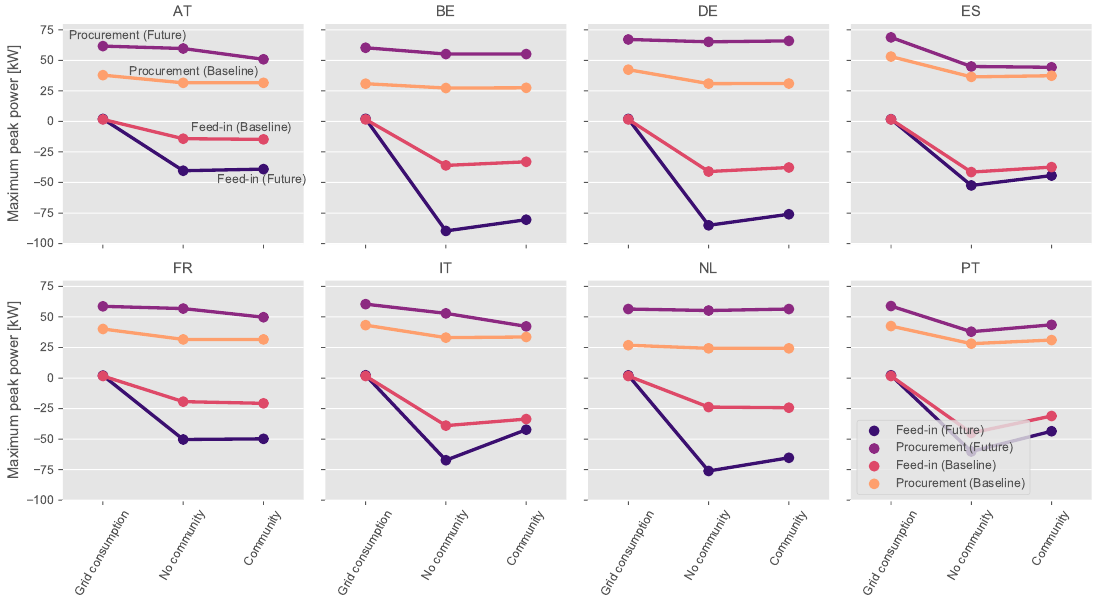
Figure 8. Peak power within one year for procurement and feed-in for all countries. The results represent discrete data (four data points per scenario). The subsidiary line connects the data points of the